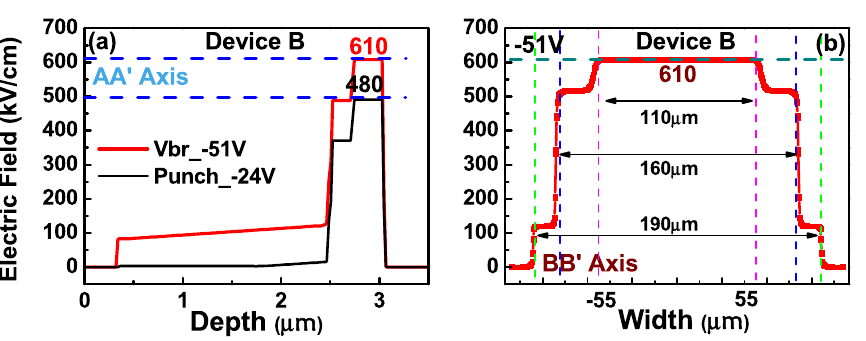
Figure 3. Electric field profiles at V pt and V br for device B along the directions. ( a ) AA ′ . ( b ) BB ′